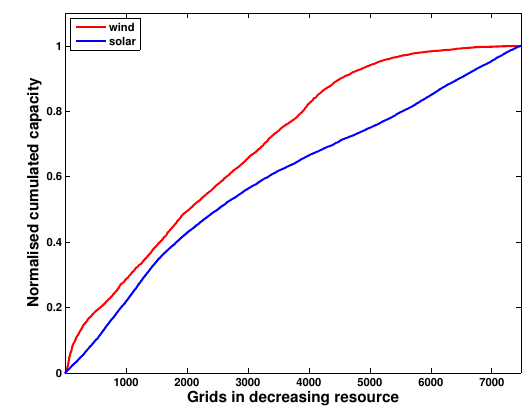
Figure 1. Cumulative distribution function of wind and photo- voltaic capacities in order by decreasing resource of wind speed and irradiance on a 7km × 7km grid for Germany